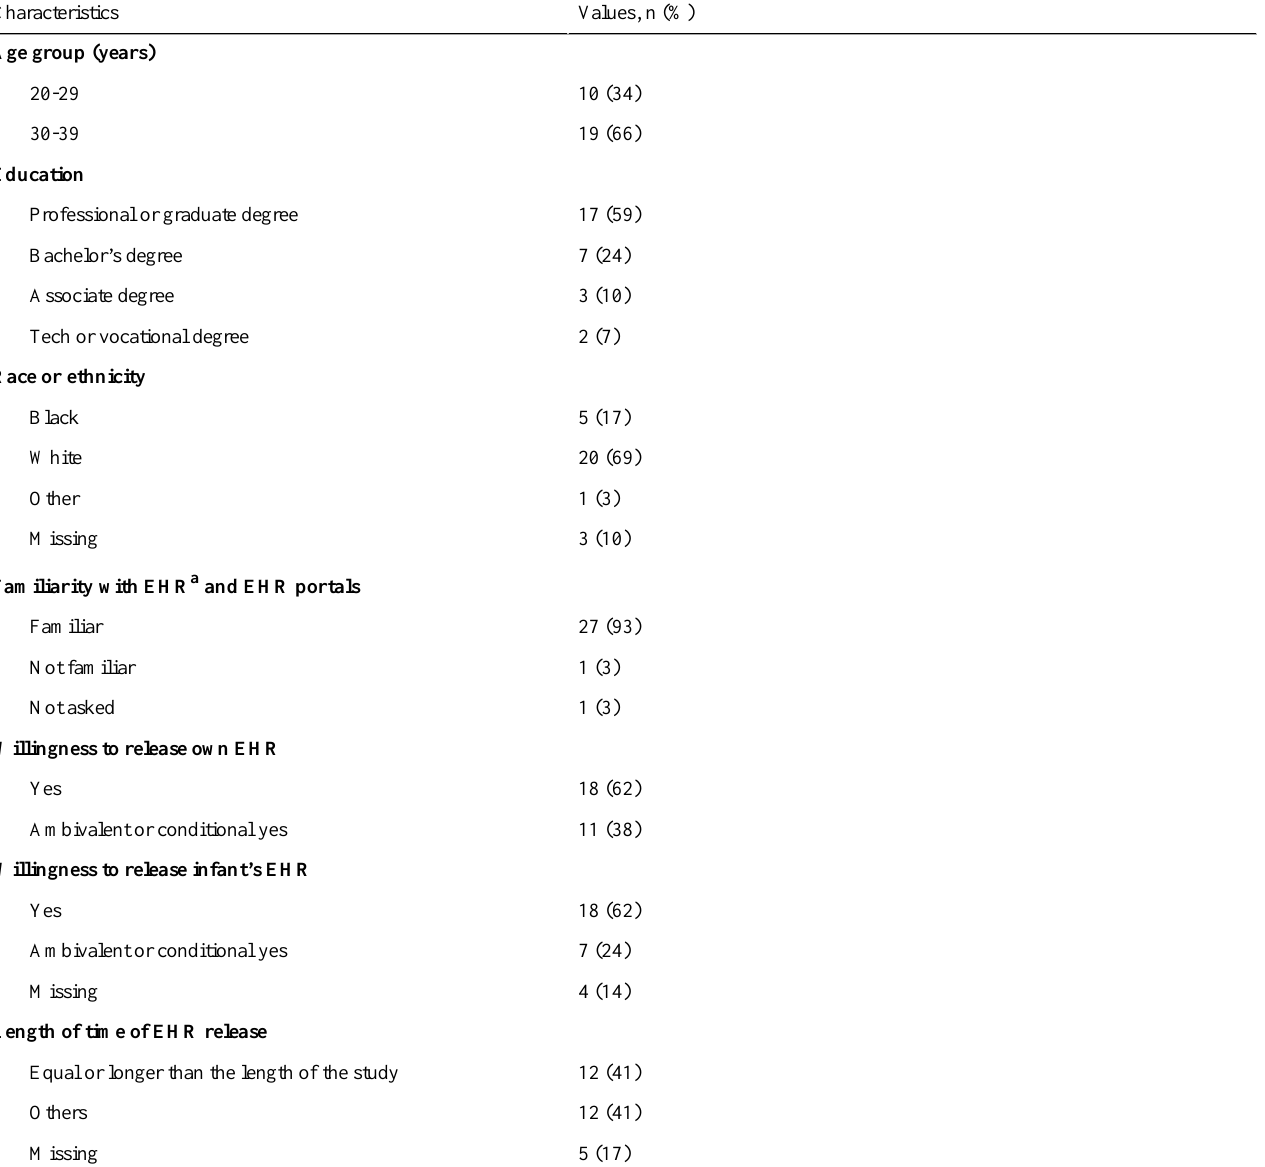
Table 2. Participant characteristics (N=29).